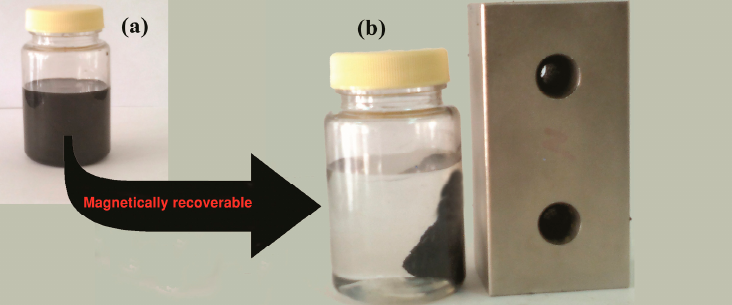
Figure 10. Powerful superparamagnetic property and simple recovery of GO/Fe 3 O 4 / L -proline catalyst using an external magnet.